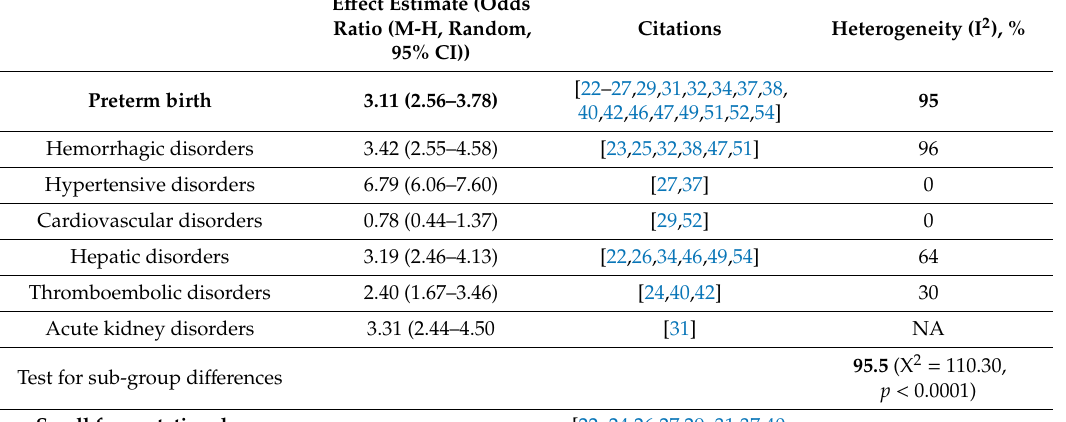
Table 3. Adverse perinatal outcomes, number of reports from studies, e ff ect estimate, citations, and heterogeneity. E ff ect Estimate (Odds Ratio (M-H, Random, 95%